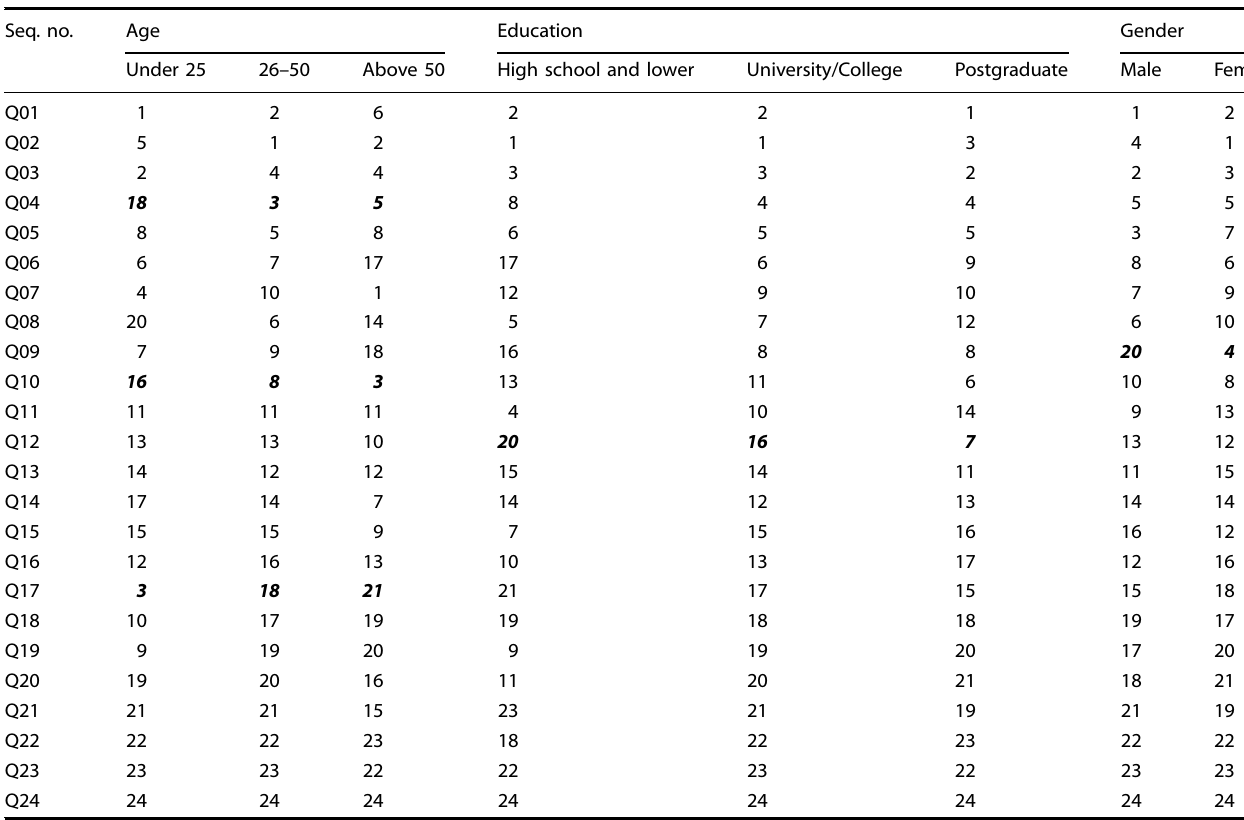
Table 4. Demographic analysis of interest